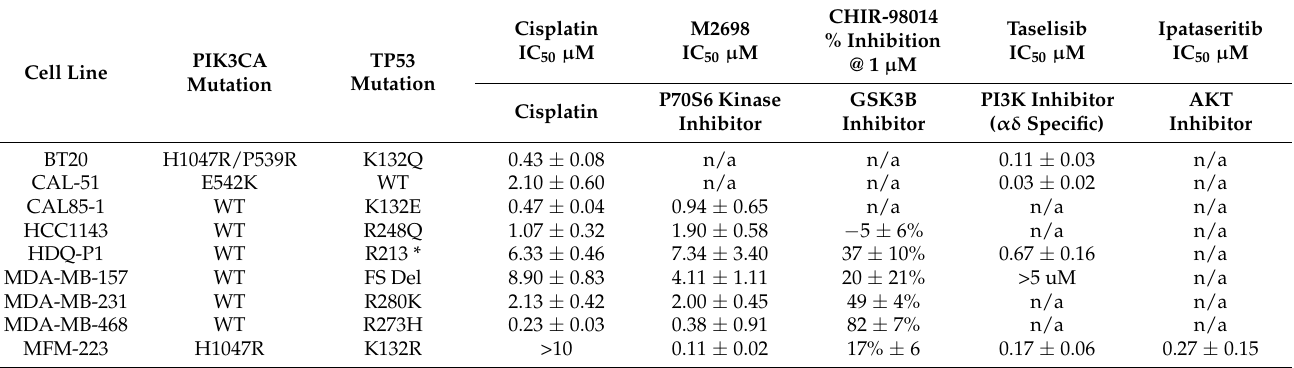
Table 3. Sensitivity of a panel of TNBC cell lines as determined by the acid phosphatase assay to cisplatin, an S6-kinase; a GSK3B; a PI3K; and an AKT small-molecule inhibitor. Standard deviations are calculated from triplicate independent assays using the CalcuSyn software ™. Mutational status of TP53 and PIK3CA were obtained from the Cancer Cell Line Encyclopaedia (https://portals. broadinstitute.org/ccle accessed on 15 February 2022).